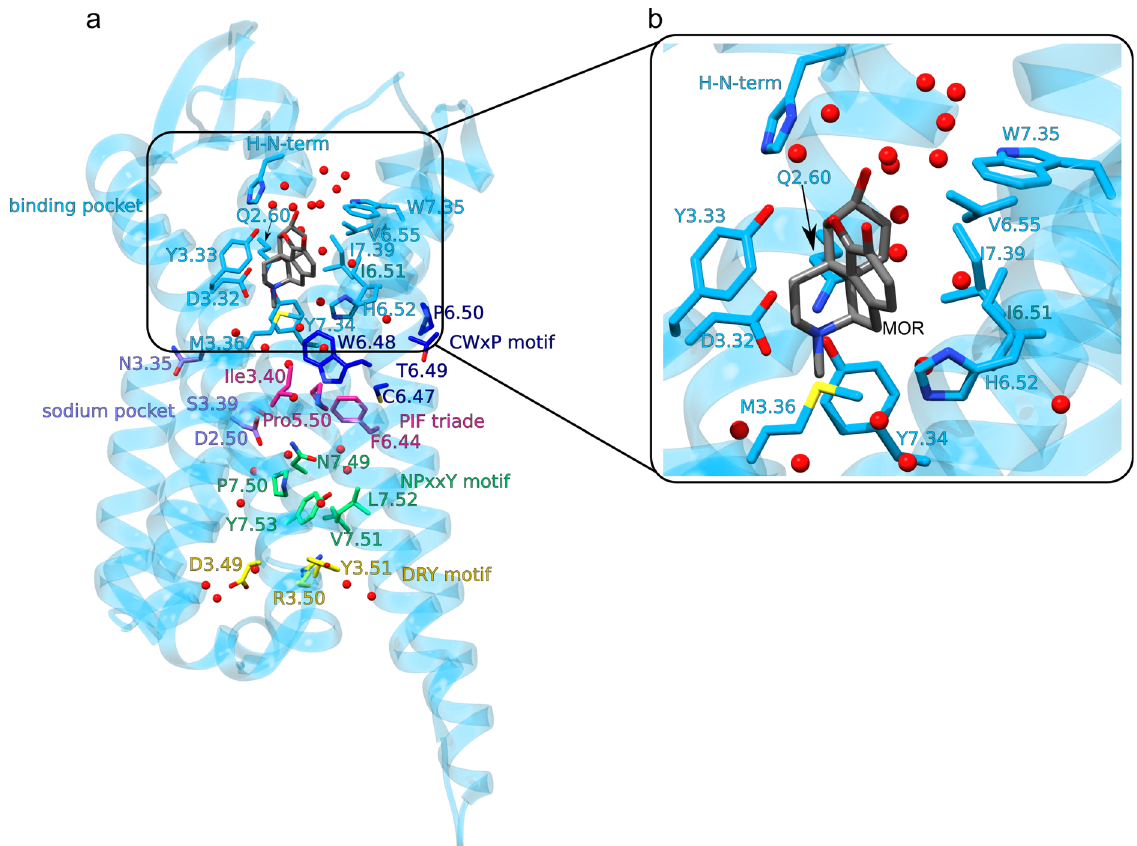
Figure 2. Architecture of the MOR. The seven TM helices inter-connect via the three extracellular loops ECLs 1-3 and the three intracellular loops ICLs 1-3. The disulfide bridge between C3.35 and C45.40 connects TM3 to ECL2. ( a ) Mouse MOR bound to morphine (PDB ID: 5C1M) [32]. The opioid binding site and amino acid residues part of the conserved GPCR motifs are shown as colored bonds. The image was prepared using UCSF Chimera 1.14 [23] and Inkscape 1.0, and is based on the structure of the active MOR (PDB ID: 5C1M) [32]. ( b ) Close view of interactions at the opioid-binding site. We removed from the structure the native crystal ligand BU72. We placed the morphine molecule into the binding site by overlapping it onto the BU72 [32]; for the structural overlap we used the common atoms of the pentacyclic moiety of BU72 and morphine. Water oxygen atoms within 3.5 Å of morphine or protein groups are shown explicitly as red spheres.